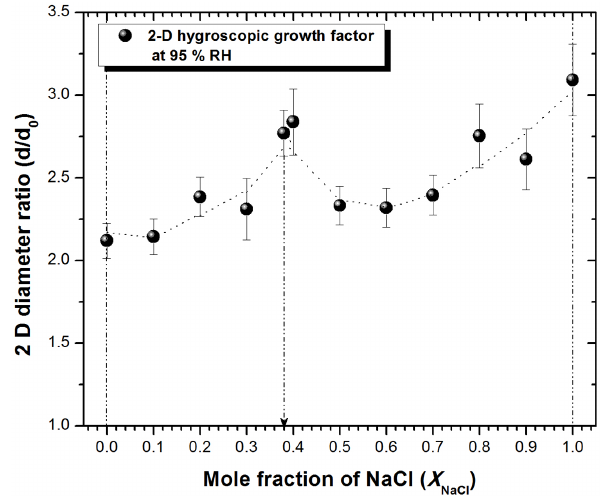
Figure 7. Hygroscopic growth factors in terms of the 2-D diameter ratios ( d 95 /d 0 where d 95 = the diameter at ∼ 95%, determined by extrapolation, and d 0 = dry diameter at lowest or ∼ 3% RH) are plotted as a function of the mole fraction of NaCl for the NaCl– NaNO 3 mixture